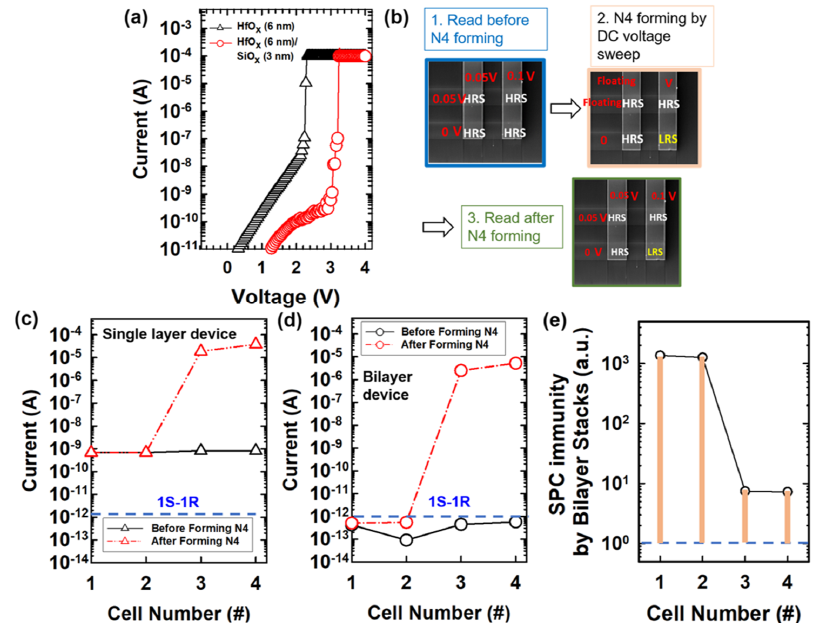
Figure 3. ( a ) Electroforming of HfOx (6 nm)(black curve) and HfOx (6 nm)/SiOx (3 nm) (red curve) devices i.e. N4 cell, (b) the design flow of experiments,(c) (d) read current of HfOx (6 nm) on standby cells before (black curve) and after N4 electroformation (red curve), (e) SPC immunity improvement by using bilayer stacked structure. The equivalent circuit of an N × N crossbar array for the one-bit line pull-up read scheme (Figure 4a). The read margin is defined as the voltage drop (ΔV) divided by the pull-up voltage applied externally, where the sneak path current caused the voltage drop when the selected cell is at a low resistance state (LRS) i.e less resistive and higher SPC. The selected cell (pink marked) is under the full-read voltage (Vread) and the unselected cell (orange marked) is under half of the V read . The pull-up resistor is utilized as the passive component for pull-up voltage (V pu ) measurement and validation. The N represents the "number fo wordline i.e. array size, and the equivalent circuit is showed that the selected and unselected RRAM cell is in parallel [36–38]. Herein, the second-order of neighboring cells i.e. (N-2) cell in the schematic, is neglected due to the ignorable interference current contribution. That is, the component in the read margin calculation is suggested to be ne- glected due to ignorable interference current contribution by second-order resistor. The equivalent circuit is simplified and includes first-order resistors in the form of (R LRS /(N- 1)) [38].